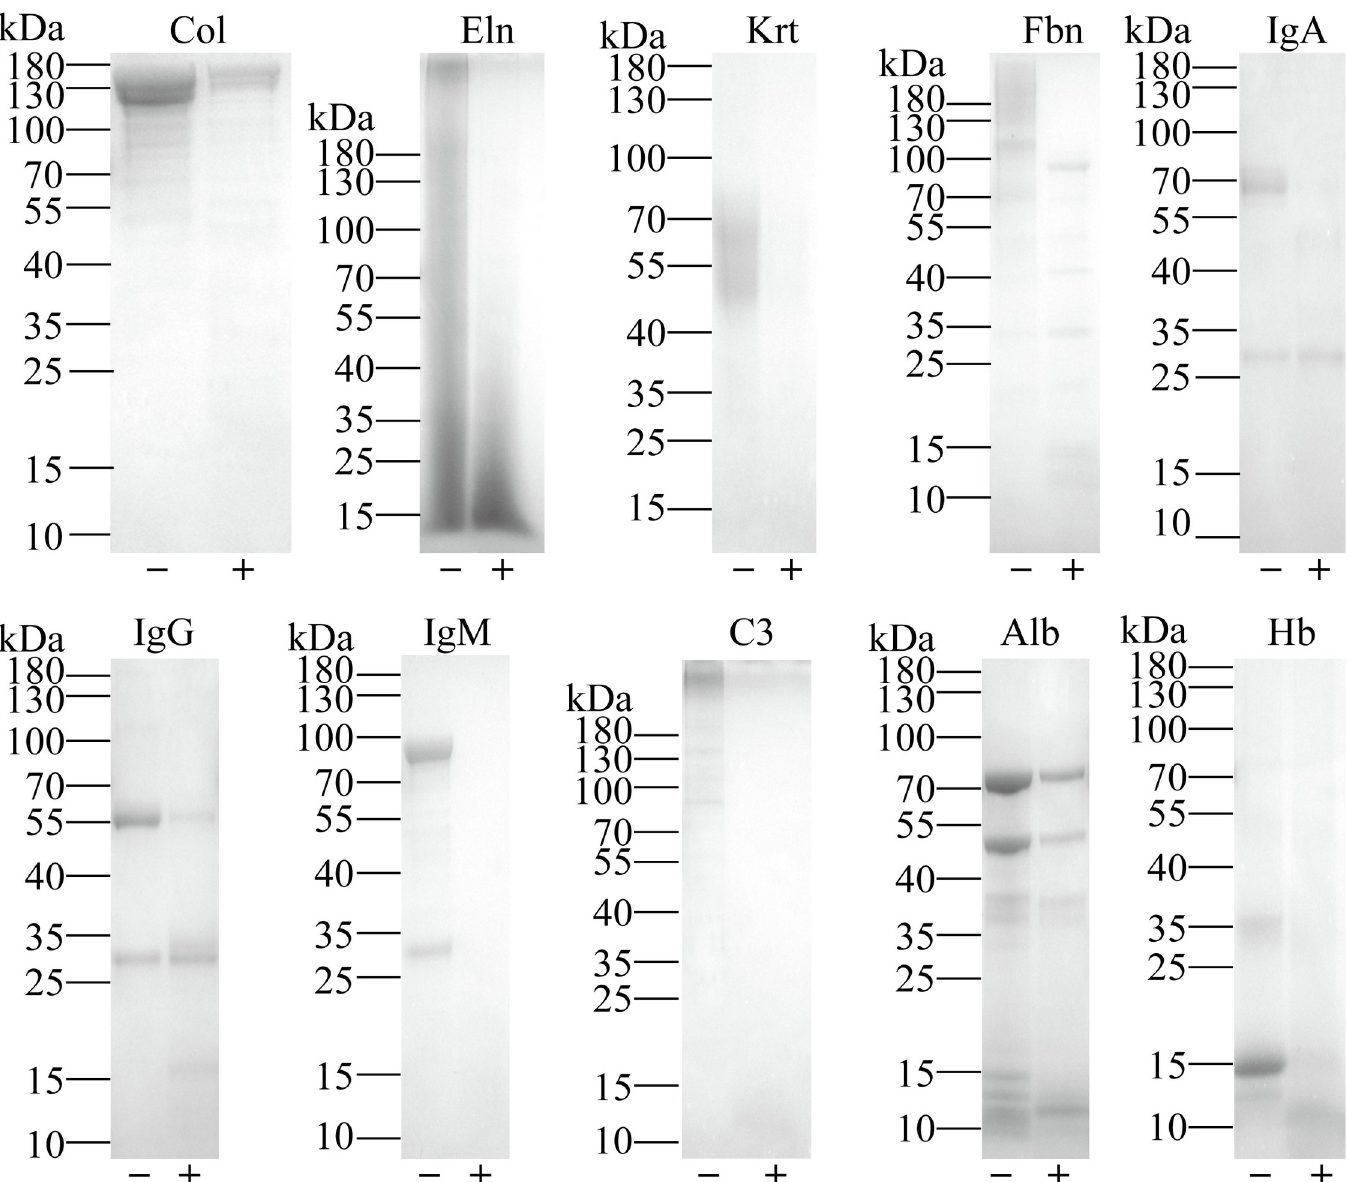
Fig 6. Digestion of selected natural substrates. Proteolytic activity of ySjCB2 against main host skin components, collagen (Col), elastin (Eln), keratin (Krt) and fibronectin (Fbn); immune system components, immunoglobulin A (IgA), immunoglobulin G (IgG), immunoglobulin M (IgM) and complement C3 (C3) and blood components, albumin (Alb) and hemoglobin (Hb). Substrates were incubated in 100 mM acetic acid-sodium acetate (pH 4.0) buffer with 10 mM DTT in the presence (+) or absence (-) of ySjCB2 for 18 h at 37˚C and analyzed by 10% SDS-PAGE. Molecular weight marker of each substrate was showed on the left side.